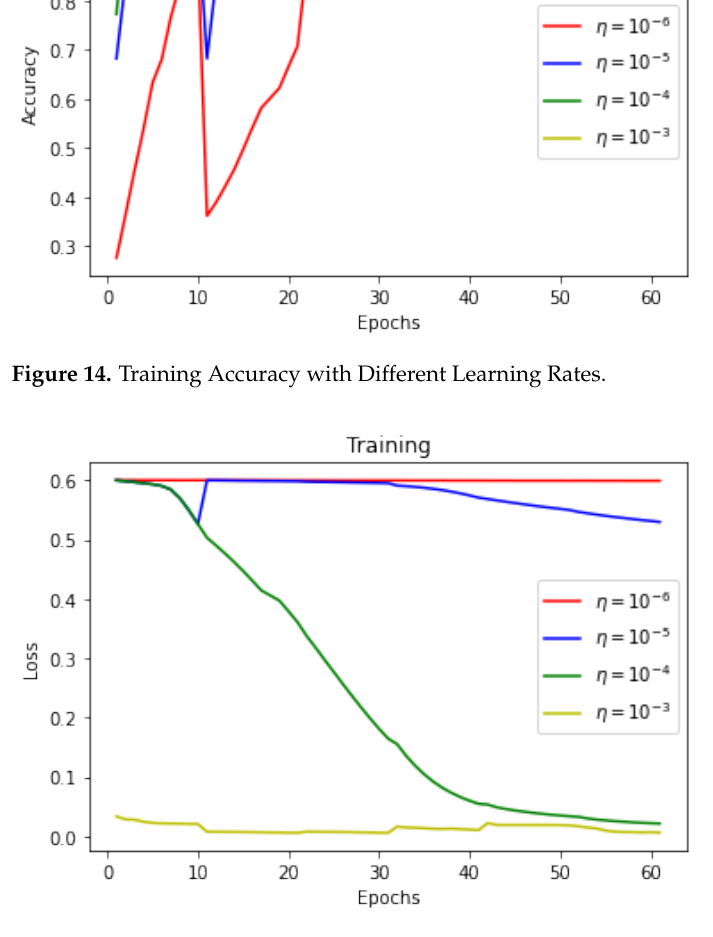
Figure 15. Training Loss with Different Learning